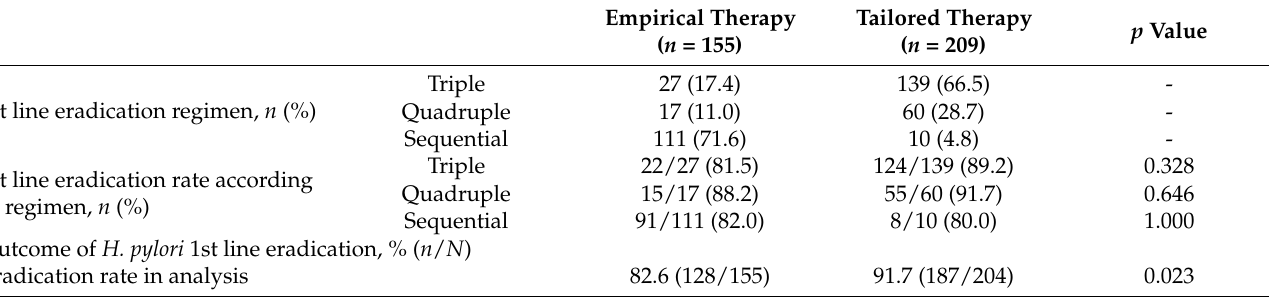
Table 2. H. pylori eradication rate of study